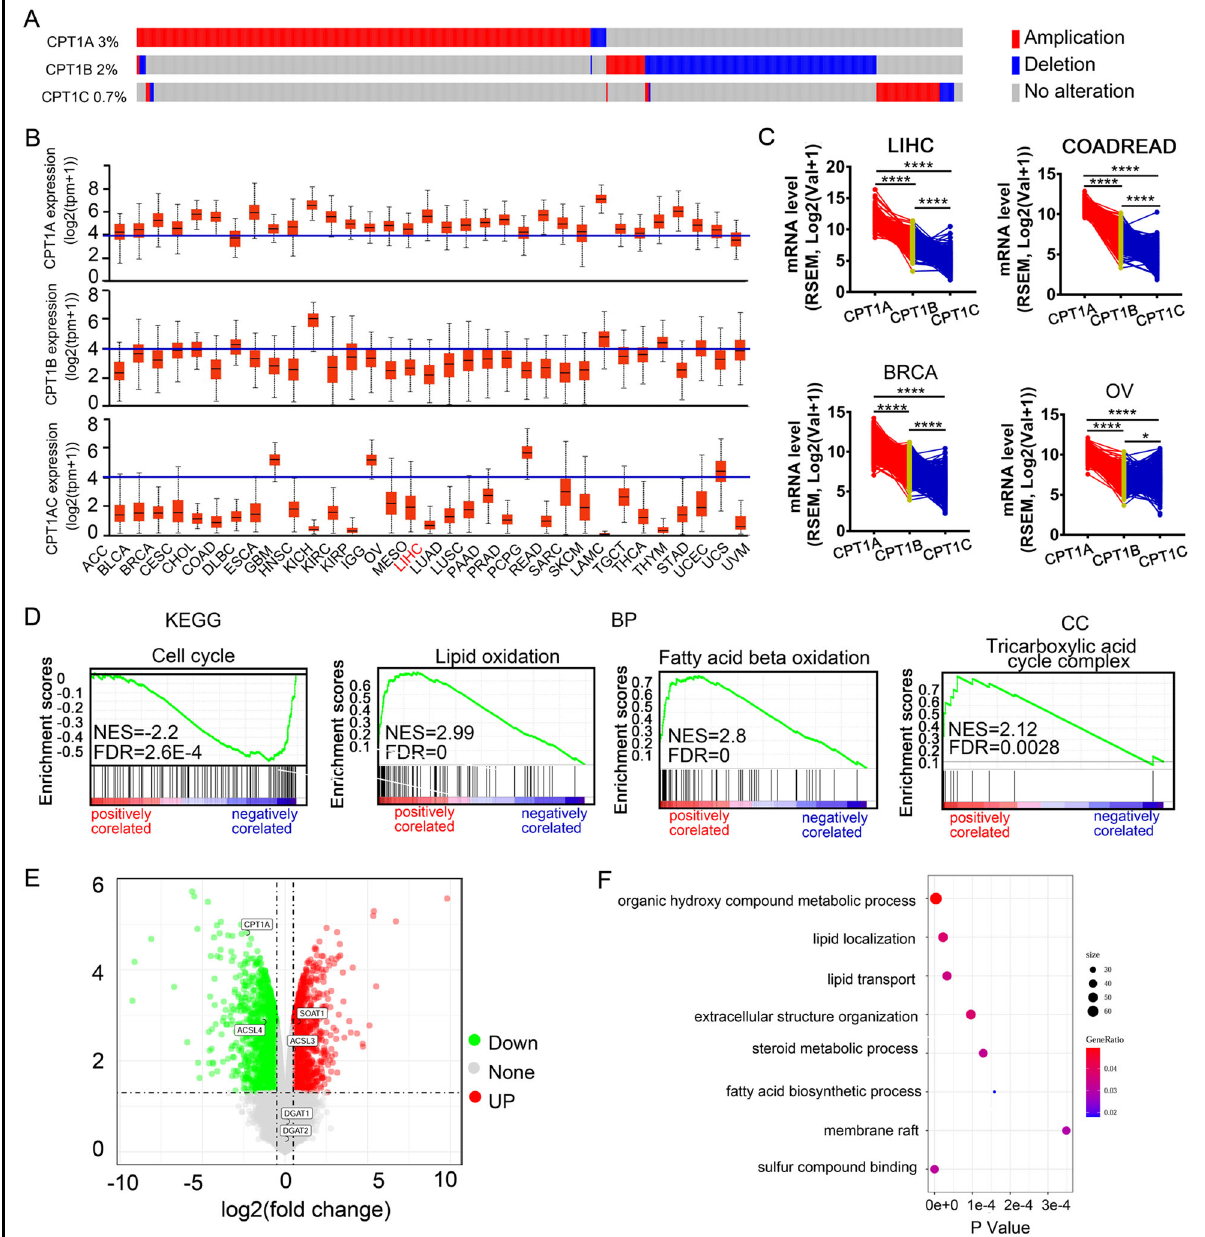
mRNA expression pattern in 30 cancer types in the TCGA database from UNICAL. C Paired pro fi les of CPT1A, CPT1B, and CPT1C mRNA expression in tumor tissues from individuals with HCC and other cancers in the TCGA database from linkedOmics. COADREAD colon adenocarcinoma and rectum adenocarcinoma, RSEM RNA-Seq by expectation maximization. D Enrichment analysis of the genes altered in the CPT1A neighborhood in HCC (LinkedOmics). BP biological processes, MF molecular functions, CC cellular component, KEGG KEGG pathway analysis. E CPT1A is inversely correlated with SOAT1. Volcano plot of differentially expressed. The red points represented upregulated genes. The green points represented down-regulated genes. F Gene ontology enrichment analysis of differentially expressed proteins in silencing CPT1A